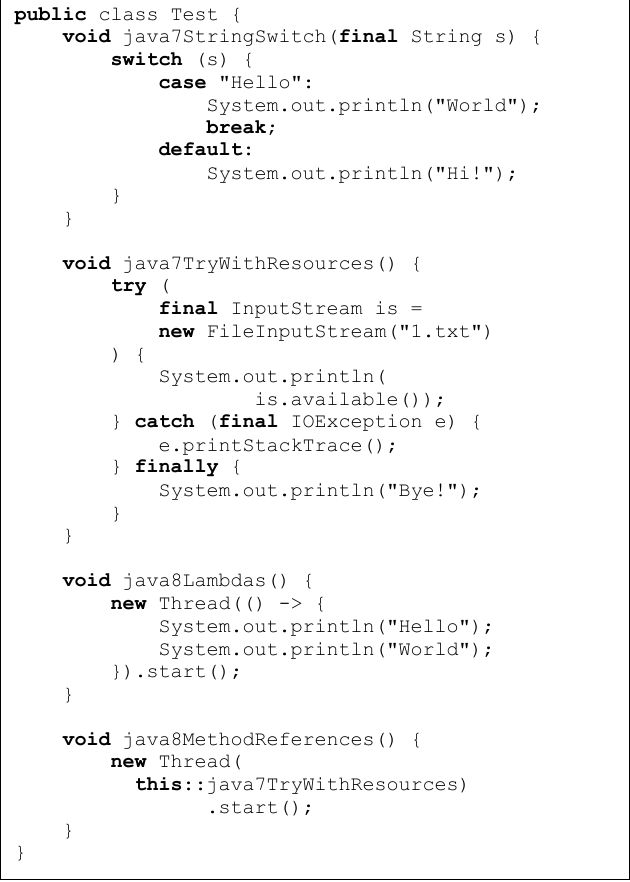
Fig. 17. Java 7/8 feature test case.